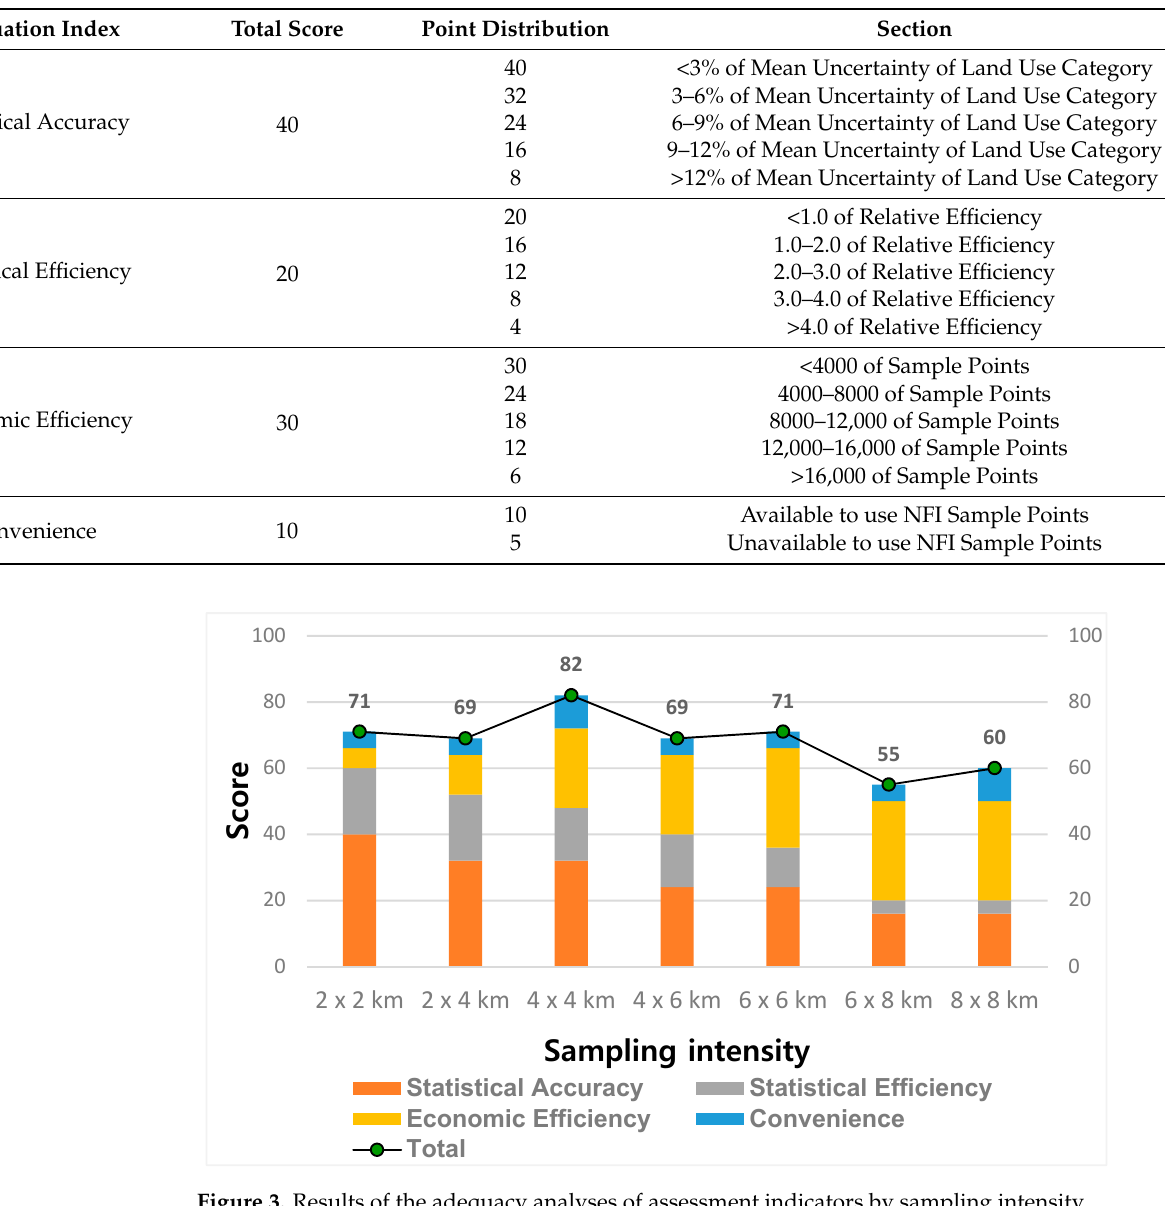
Table 7. Assessment indicators and quantification methods for optimal sample intensity decision.